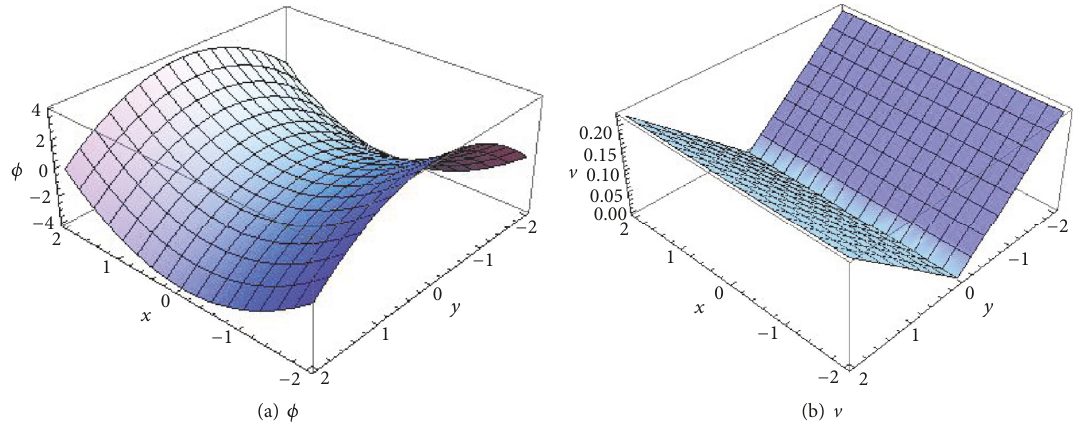
Figure 1: Plots of profiles of absolute value of 𝜙 and velocity V when Ω ’s